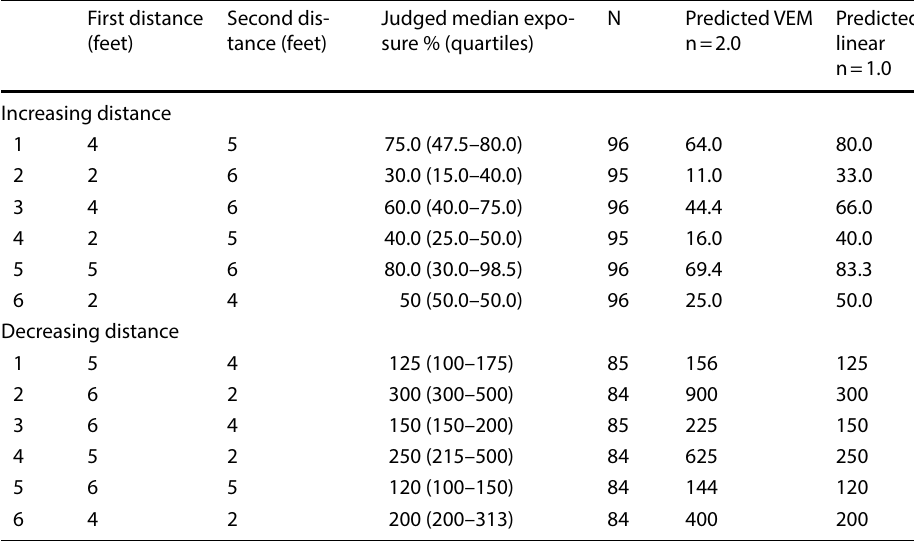
Table 1 Medians and quartiles of exposure judgments and predictions according to VEM, n = 2.0 and the linear model with n = 1.0. Increasing and decreasing distance